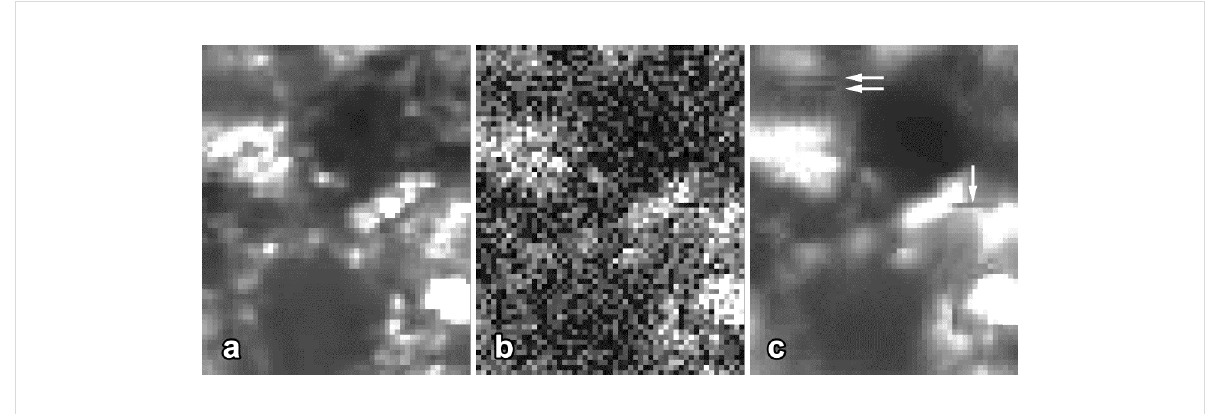
Figure 1: Enlarged optical section of gut tissue in intravital 2-photon microscopy: a) ground-truth signal, b) ground truth with digitally added noise, c) image reconstructed by the original BM3D algorithm published by Dabov et al. [15]. Note that the reconstructed image contains a number of struc- tures which are not seen in the original image and thus represent artefacts